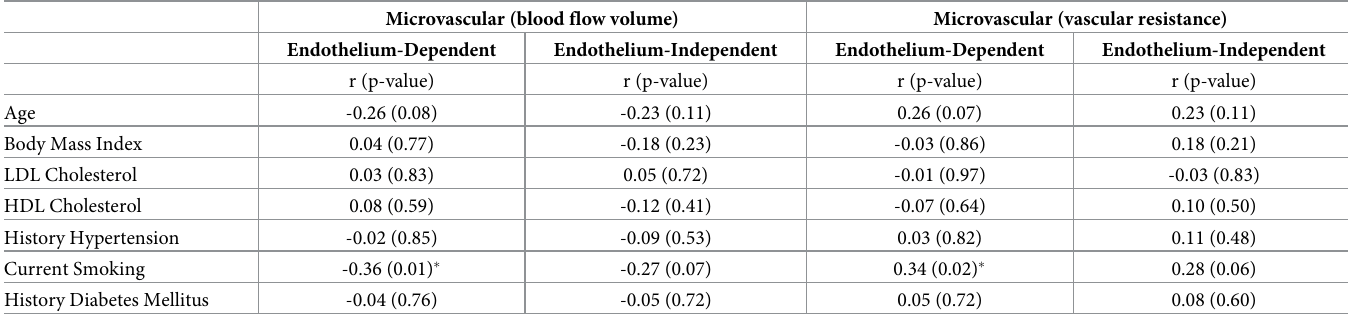
Table 4. Spearman correlations and 95% confidence intervals between microvascular vasomotor function and atherosclerosis risk